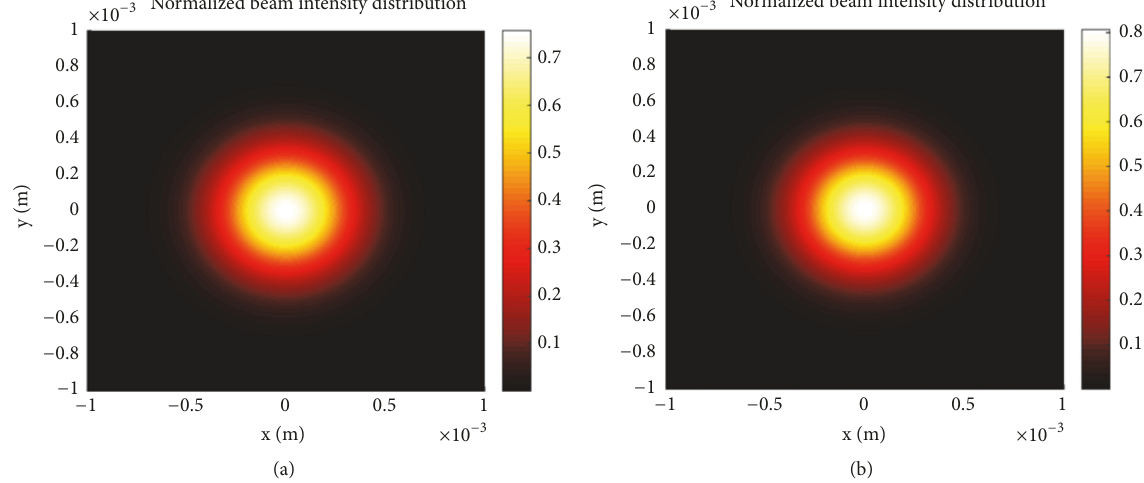
Figure 7: Normalized beam intensity distribution of emerging beam on plane Mirror B cross section for different concentration of NaCl solution, 𝜔 0 =0.1 × 10 −3 m, 𝜔 𝑝𝑒 = 𝜔 𝑝𝑚 = 2𝜋 ] ×√2.55 , 𝑍 𝑅 =4.9646cm, 𝐿 =2 𝑍 𝑅 , 𝑅 = 𝑍 𝑅 , 𝑙 =0.2m, 𝑟 =0.2m, and 𝜆 =632.8nm fixed: (a) purified water and (b) 25% NaCl